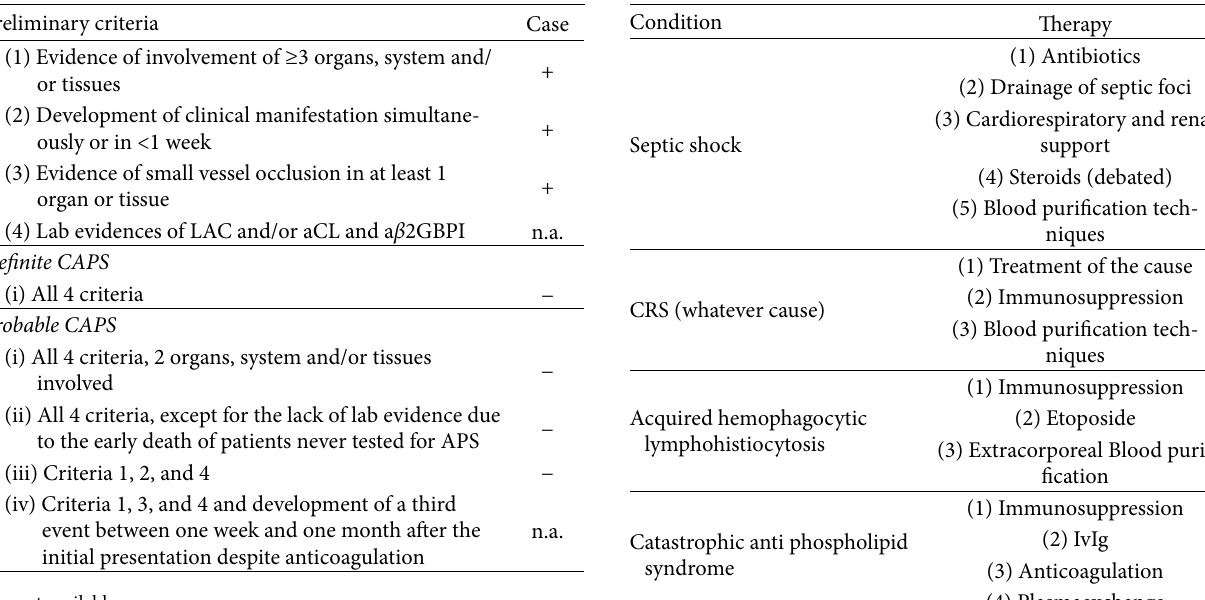
Table 4: Diagnostic criteria for CAPS (from [29]).